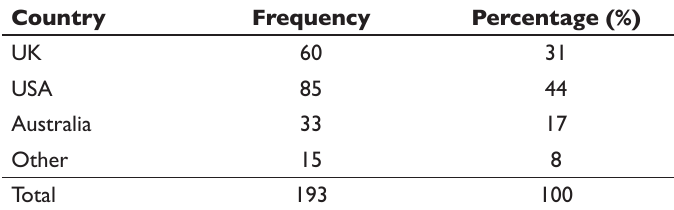
Table 2: Distribution of the literature by country of study Country Frequency Percentage (%) UK 60